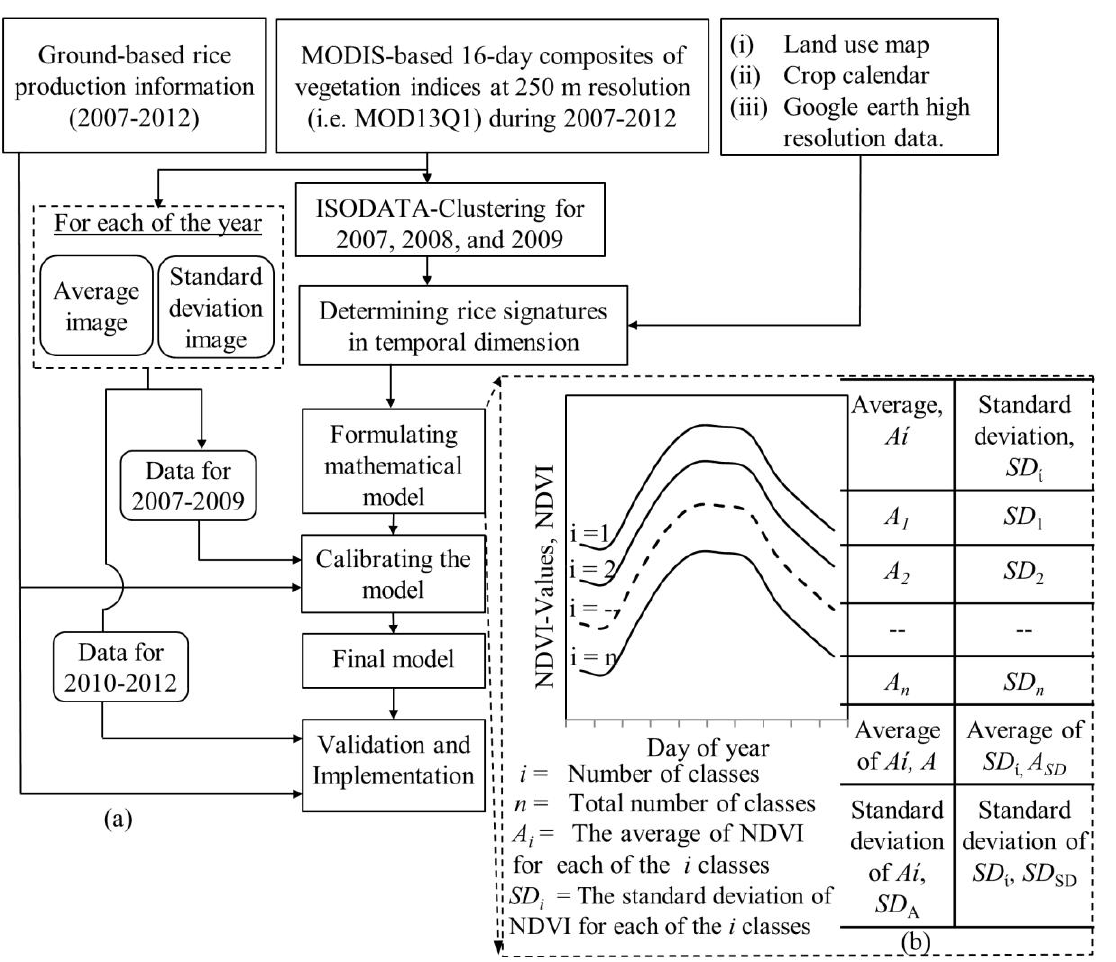
Figure 2. ( a ) Schematic diagram of the proposed method; and ( b ) the details of formulating a mathematical